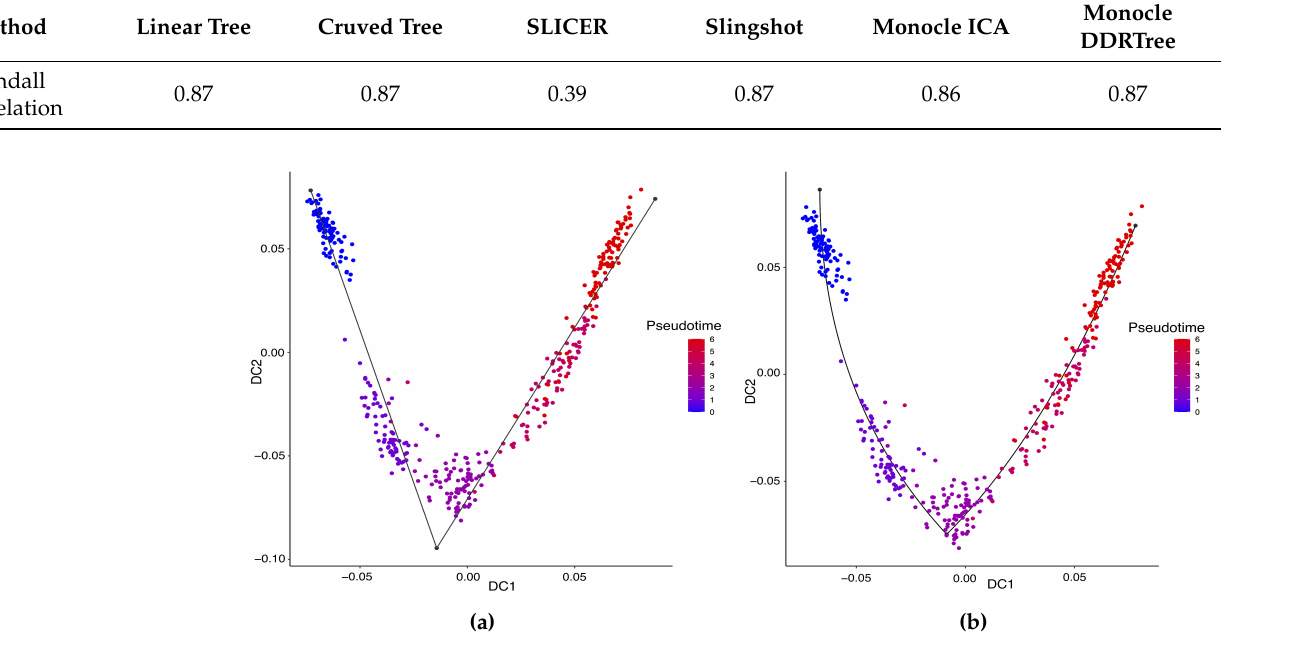
Figure 4. Estimated cell trajectories by our linear STS and curved tree methods on the mouse ES cell dataset. ( a ) Linear tree method. ( b ) Curved tree